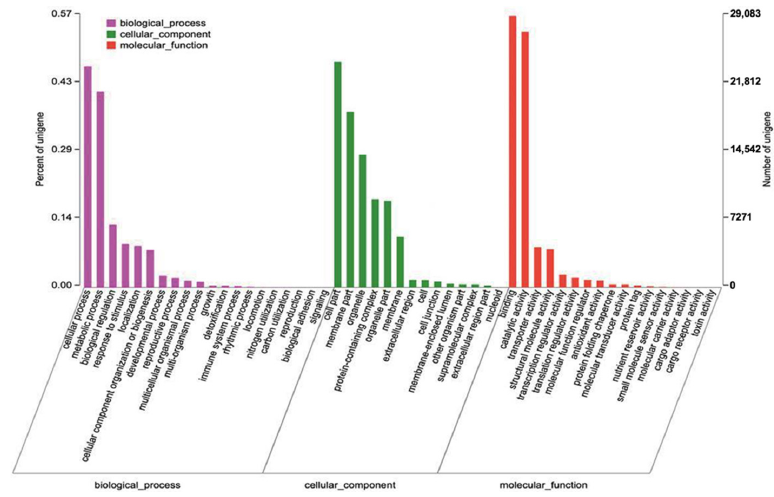
Figure 4. GO classification of unigenes.